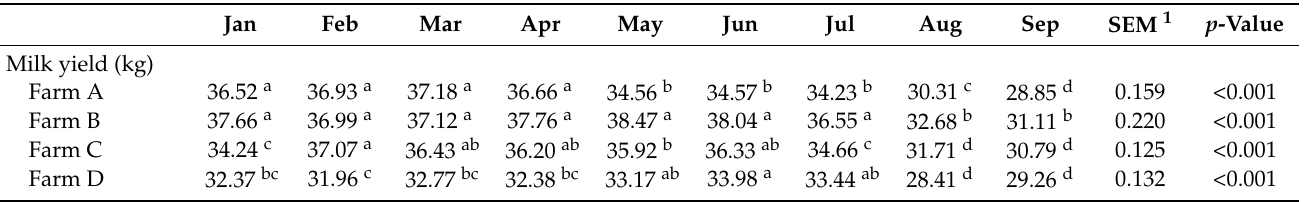
Table 2. Milk yield of lactating Holstein cows using the robot milking system at different farms from January to September.